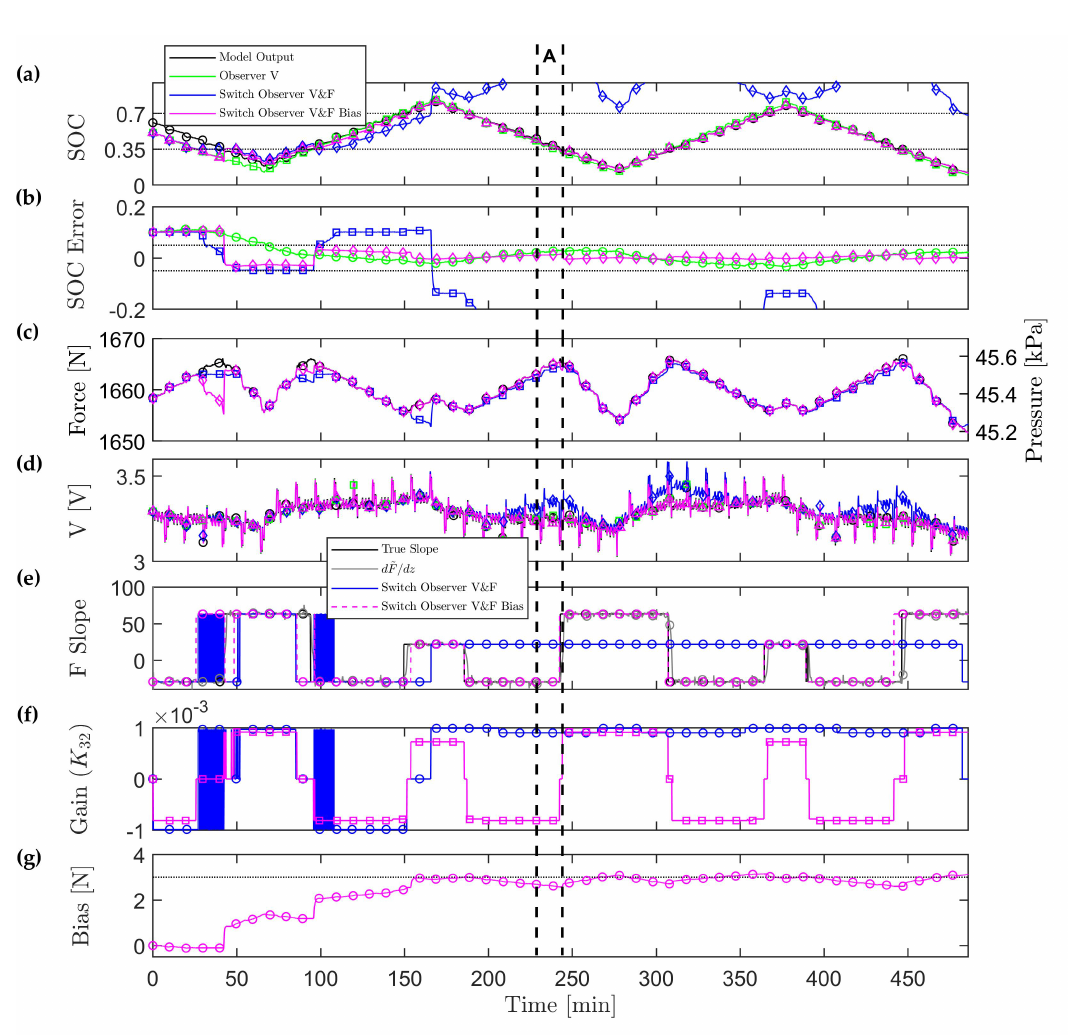
Figure 6. Simulation assuming accurate modeling using Switch Observer V&F Bias observer with an emulated bias of 3 N and 10 % (0.1) initial SOC error. ( a ) Comparison of the simulated state of charge (SOC). Is clear from the results that Switch Observer V&F without bias estimation diverges from the simulated SOC. Therefore, bias estimation is needed in the developed observer. ( b ) Comparison of the state of charge (SOC) error with the dashed lines representing the target ± 5% bound. SOC errors greater than 20% are obtained with the Switch Observer V&F without bias estimation. It is shown that with bias estimation the SOC error is within the 5% estimation error bound (EEB). ( c ) Comparison of the simulated force and observer outputs. The bias state permits deviation in the force output, without compromising SOC estimation. For generalization of the results to the other cell sizes, the pressure is shown. ( d ) Comparison of the simulated terminal voltage. ( e ) Comparison of the true slope with the estimated slope d ˜ F and observer output. ( f ) Comparison of the feedback gain K 32 from force to dz SOC based on the switching logic. As shown in region A, denoted by the black dashed horizontal lines, when the observer and estimated slopes mismatch, the gain is set to zero. ( g ) The observer estimates the bias state which converges to the true bias as shown by the black horizontal dashed